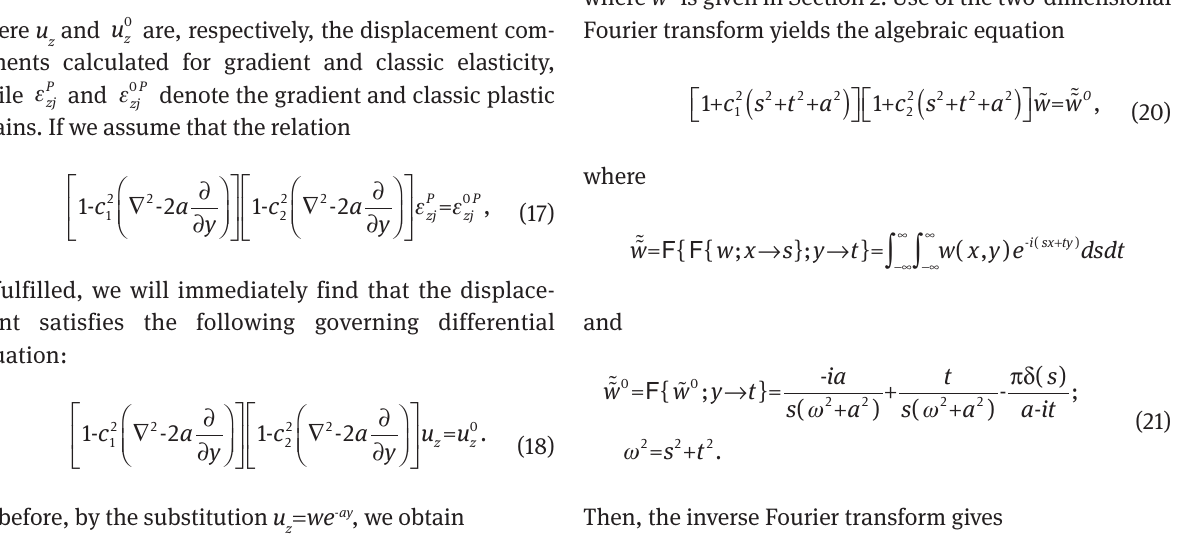
Figure 2 The elastic strain components, (A) ε dislocation in an FGM when a = 0.5 and c strain gradient elasticity. The strain values are given in units of b / (4 π c ). 1